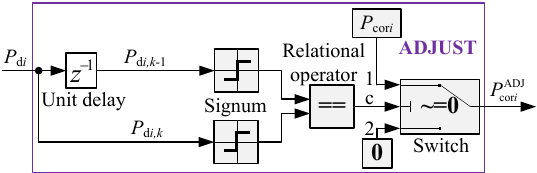
Figure 5. Schematic block diagram representation for P cor i adjustment in the CA i .